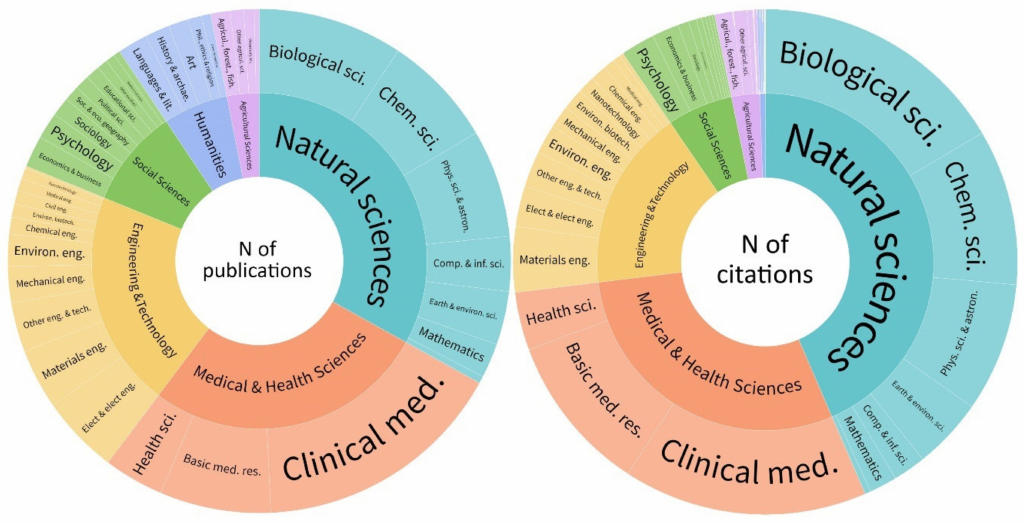
Figure 1. Distribution of publications and citations to the Organisation for Economic Co-operation and Development (OECD)